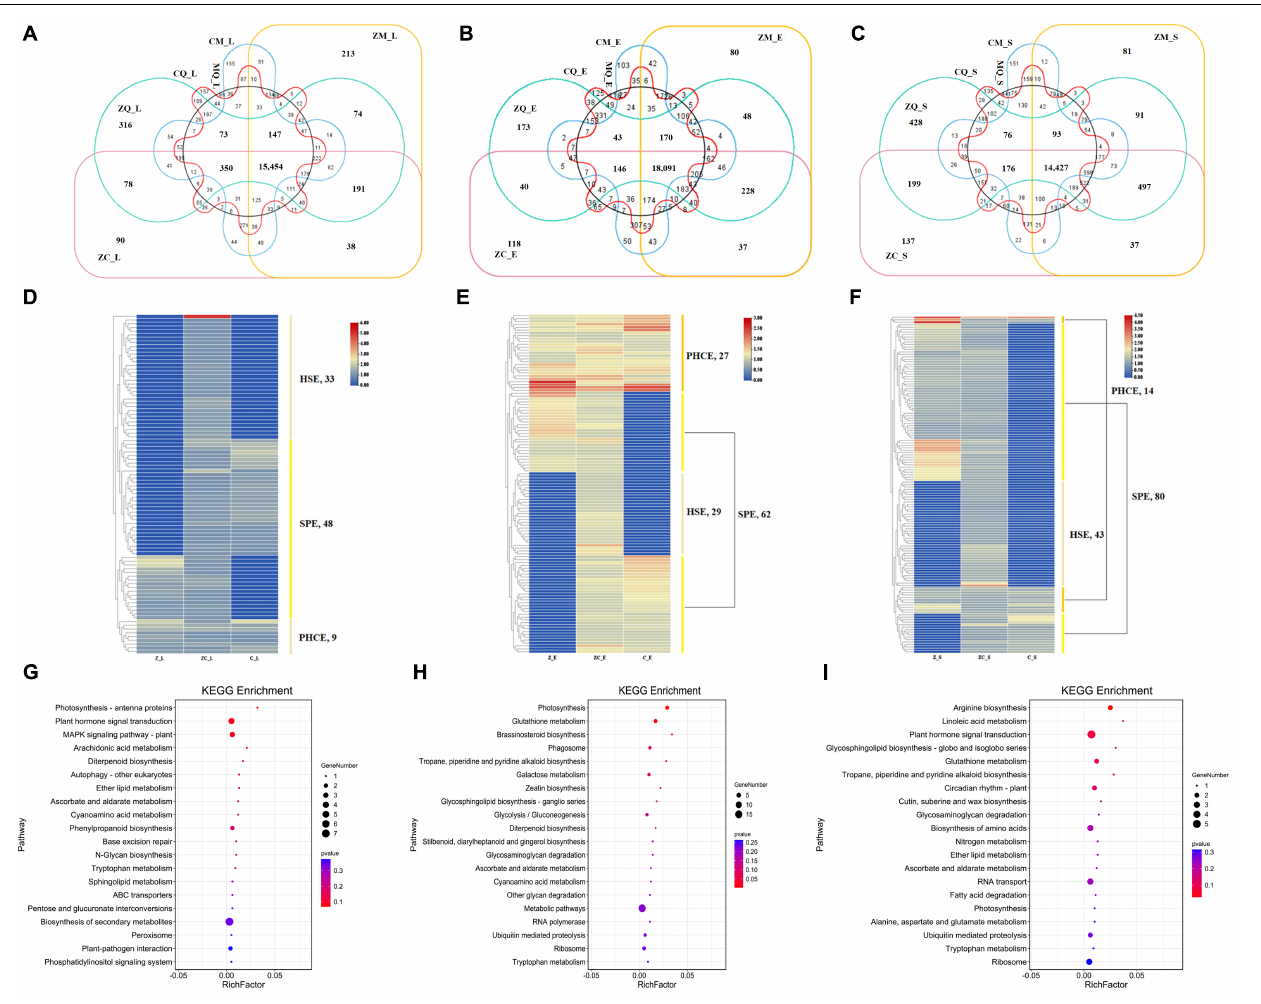
FIGURE 4 | Gene expression specificity of Zhengdan958 in different tissues. The DEGs of Zhengdan958-specific genes in leaves (A) , ears (B) and seeds (C) , and their expression patterns in leaves (D) , ears (E) and seeds (F) and the enrichment biological pathways in leaves (G) , ears (H) and seeds (I) . The Venn diagrams (A–C) show the distribution of DEGs of Zhengdan958-specific genes, and the overlapping regions represent the genes that are co-expressed among/between hybrids. The transition of colors from red to blue in heat maps (D–F) shows that the expression abundance of DEGs changes from high to low, the color bands on the right indicate different gene expression types, and the number of genes is listed near the type names in the figures. The size of dots in the bubble charts (G–I) represents the number of genes, and the color of the dots representing the P -value which listed in the